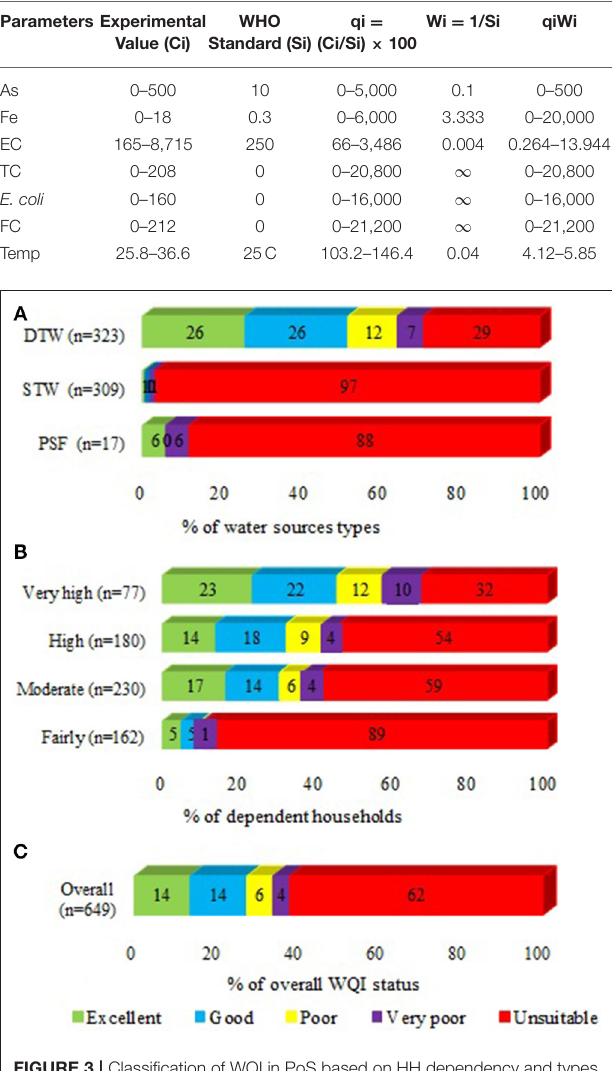
FIGURE 3 | Classification of WQI in PoS based on HH dependency and types of water sources: (A) % of water sources types, (B) % of dependent HH, and (C) % of overall WQI